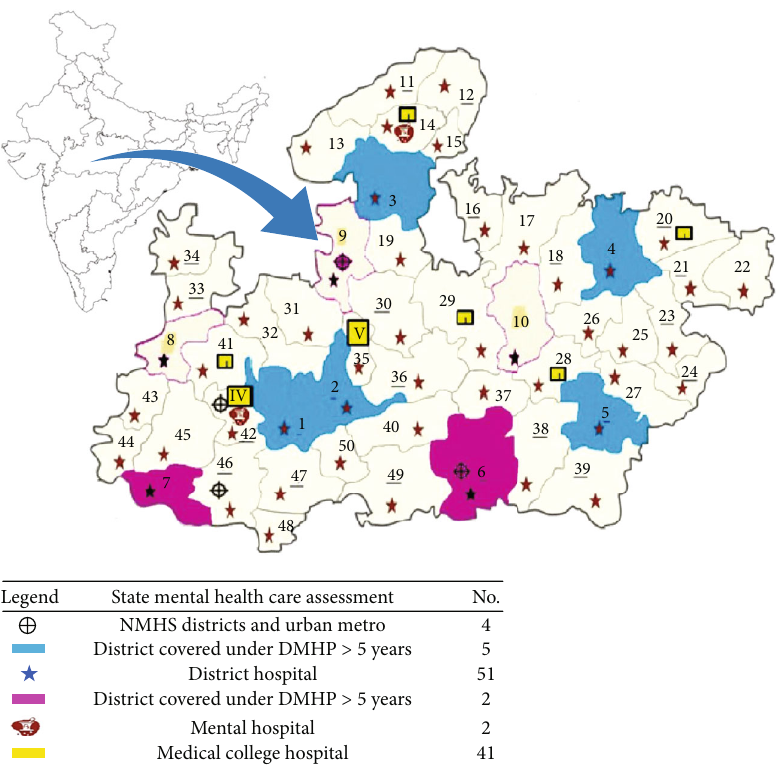
Figure 1: Map of Madhya Pradesh depicting health and mental health institutions in the